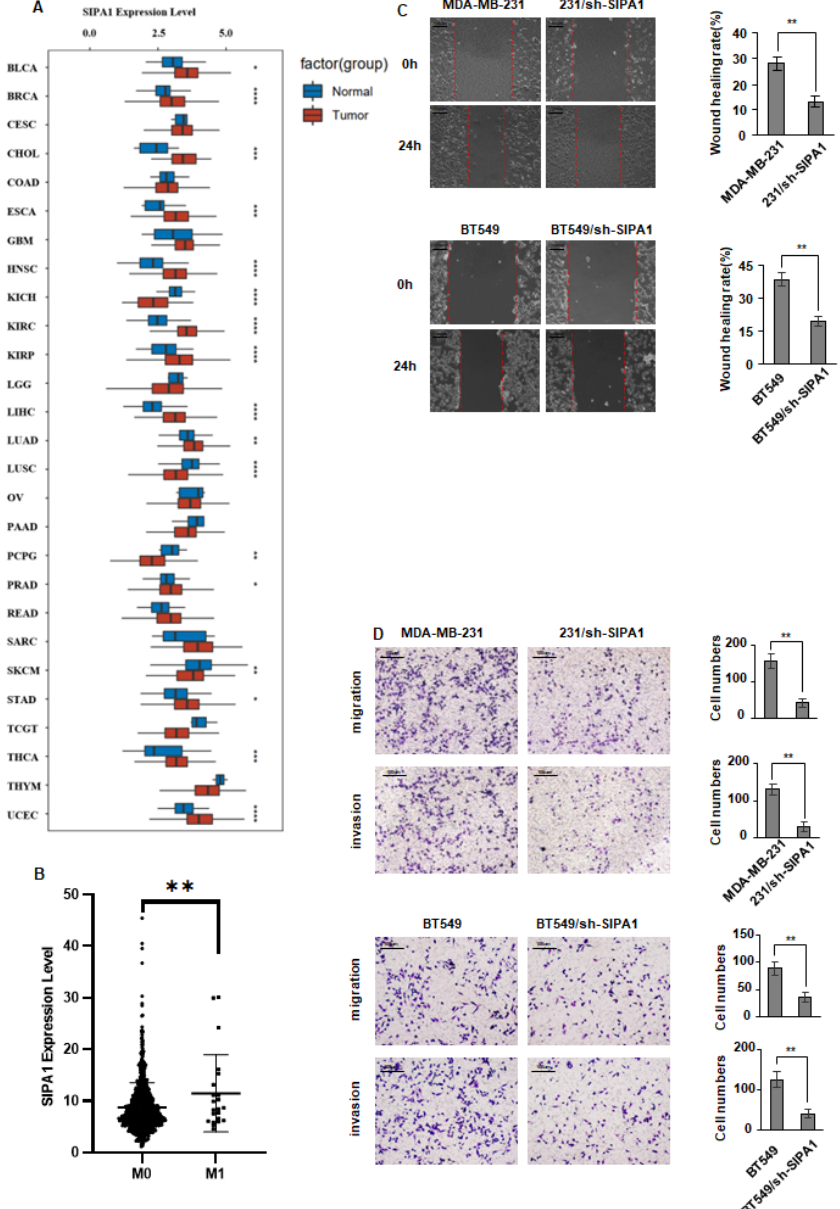
Figure 1. SIPA1 expression is elevated in breast cancer . ( A ) The expression of SIPA1 in various tumor tissues is different from that in normal tissues. ( B ) The difference in SIPA1 expression between breast carcinoma in situ and metastatic tissues. ( C ) Cell-wound-healing ability was inhibited in SIPA1 knockdown cells. ( D ) Chamber invasion ability was inhibited in SIPA1 knockdown cells. Data represent the means ± SD. ** p < 0.01.